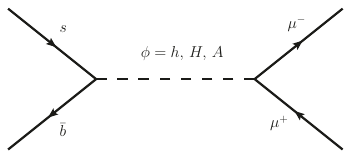
Figure 11 . Feynman diagrams that contribute to (a) (cid:28) exchange of a scalar boson (cid:30) . We omit both the bubble diagrams for the LFV decay (cid:28) because only serve to cancel the ultraviolet divergences.